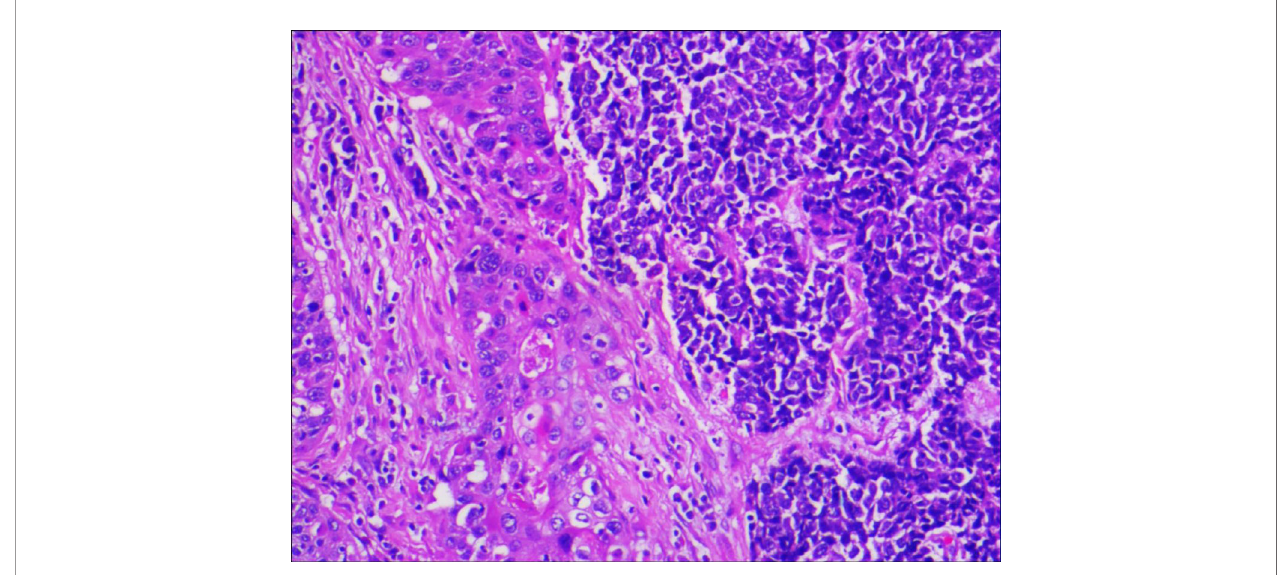
FIGURE 2 | Microscopic examination con fi rmed that the ureteral tumour cells were composed of two parts, and each component accounted for half of it (magni fi cation,